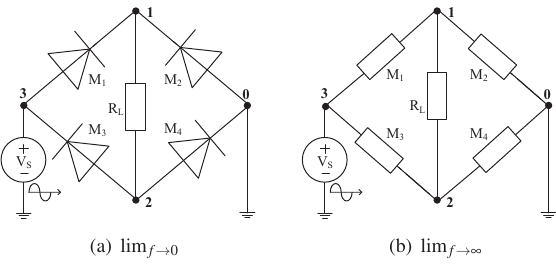
Fig. 5 : Approximate circuit equivalents: (a) Graetz circuit for very low frequencies, (b) Wheatstone circuit for very high